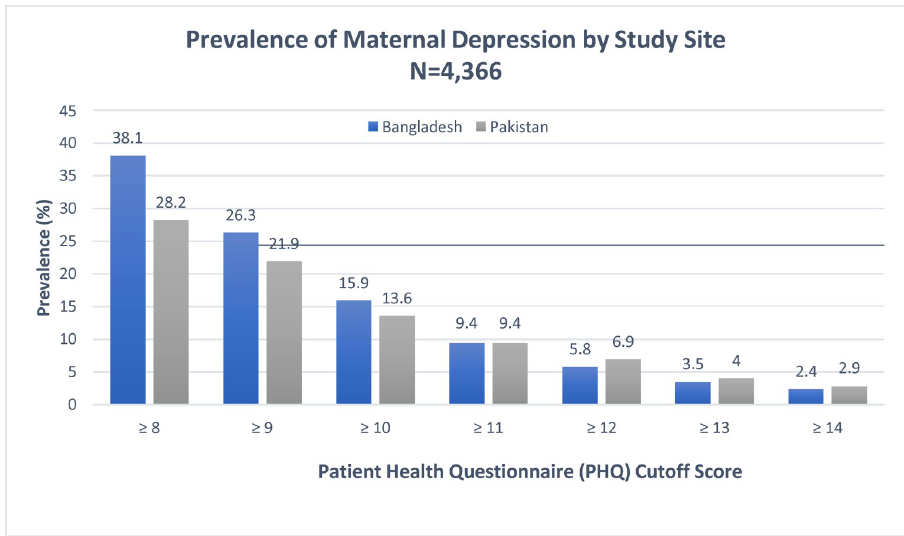
Fig 2. Prevalence of prenatal maternal depression by study site (PHQ-9 cutoff score 8–14).